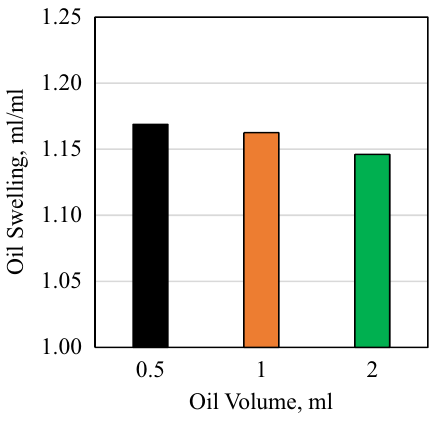
Fig. 4 Effect of oil viscosity on oil swelling at 1500 psi and 40 °C using 1 ml oil